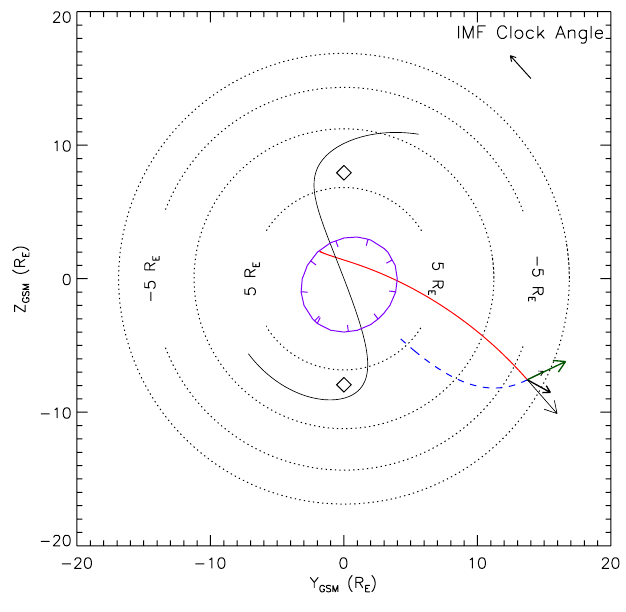
Fig. 9. Histograms of the angle between the observed FTE veloc- ities (projected onto the model magnetopause) and (a) the near- est Cooling model velocity ( V HTN or V HTS ), and (b) the model magnetosheath velocity (dotted line). These histograms include all FTEs which had an angular uncertaintly of less than 30 ◦ , a velocity within 30 ◦ of the model magnetopause surface and a characteristic scale of greater than 5000km (total 118